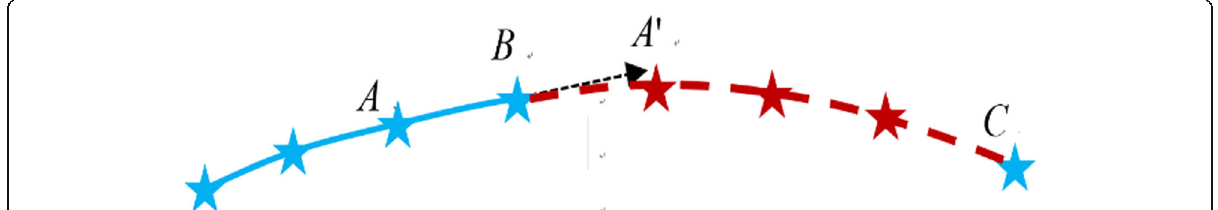
Fig. 4 Example for Bezier trajectory completion method